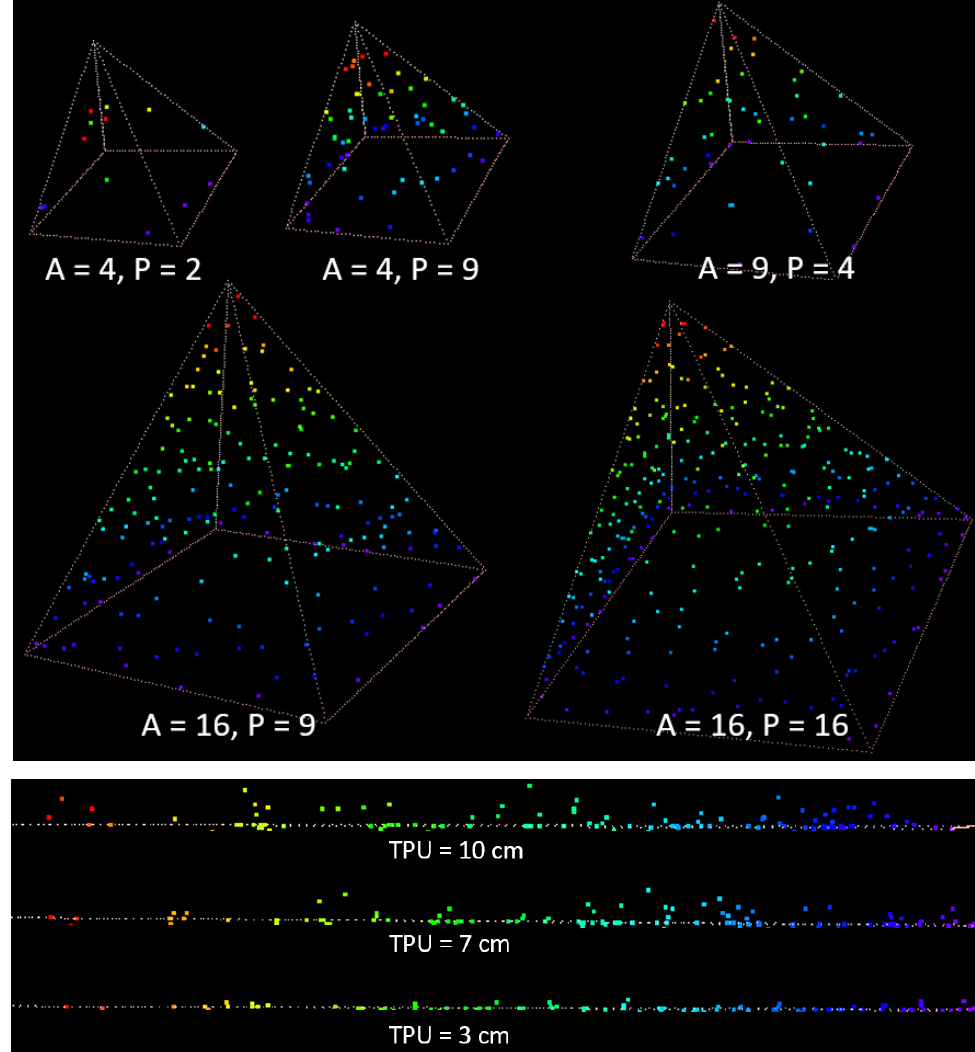
Figure 9. Selected simulation inputs. Projected area of a pyramid (A), data density (P), and sensor performance in terms of TPU.